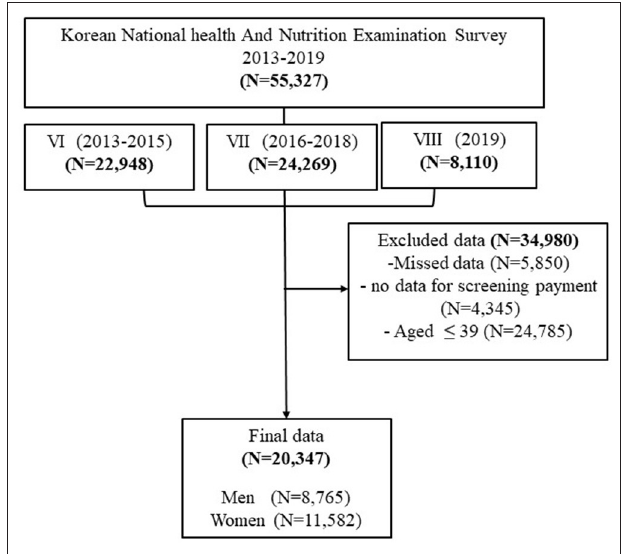
FIGURE 1 | Flow diagrams showing selection of the study population.